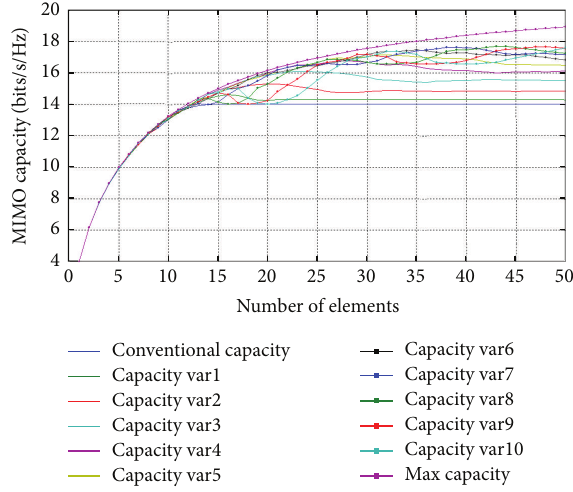
Figure9:MIMOcapacityforthespiralgeometrywithaSNR=15 dB /𝜆 . and a radius of 0.25 𝑑 spa